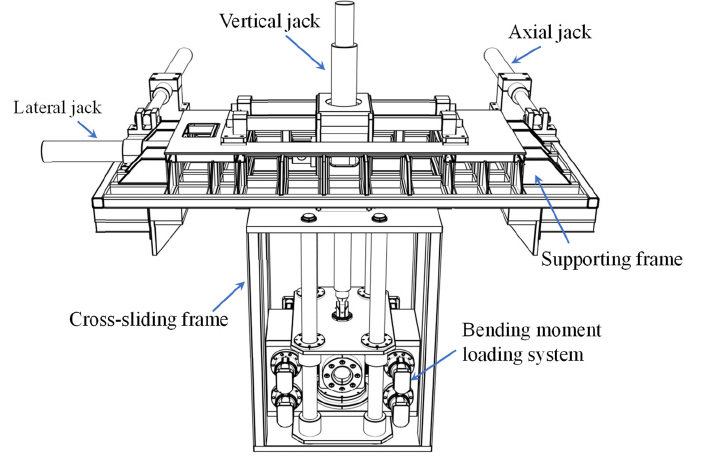
Figure 4. Assembly of the supporting frame, cross-sliding frame, and displacement and bending moment loading